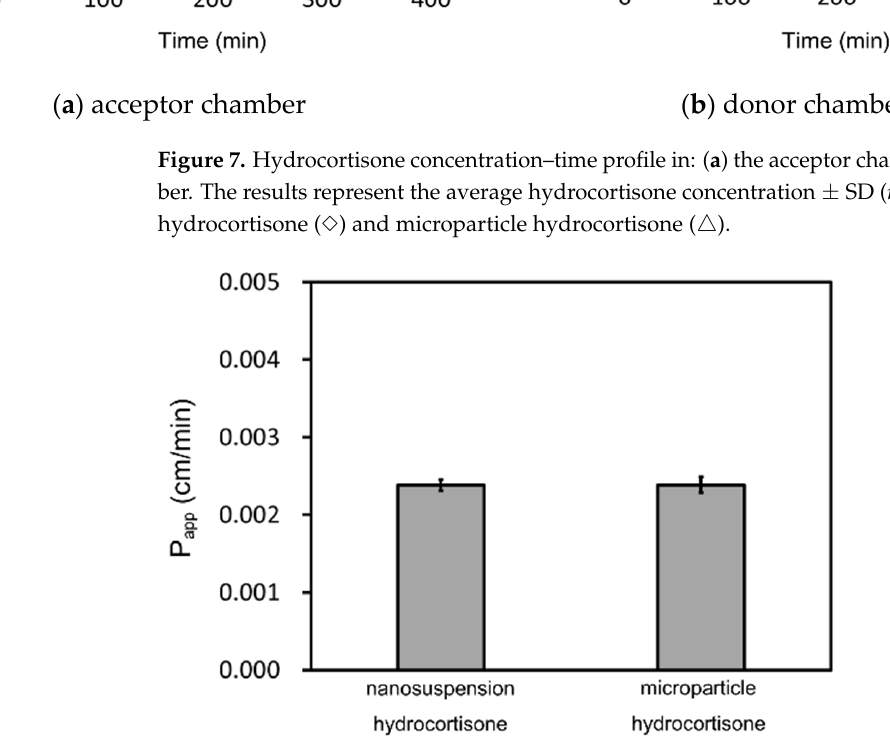
Figure 8. Calculated P app of hydrocortisone. The results represent the average P app ± SD ( n = 3).